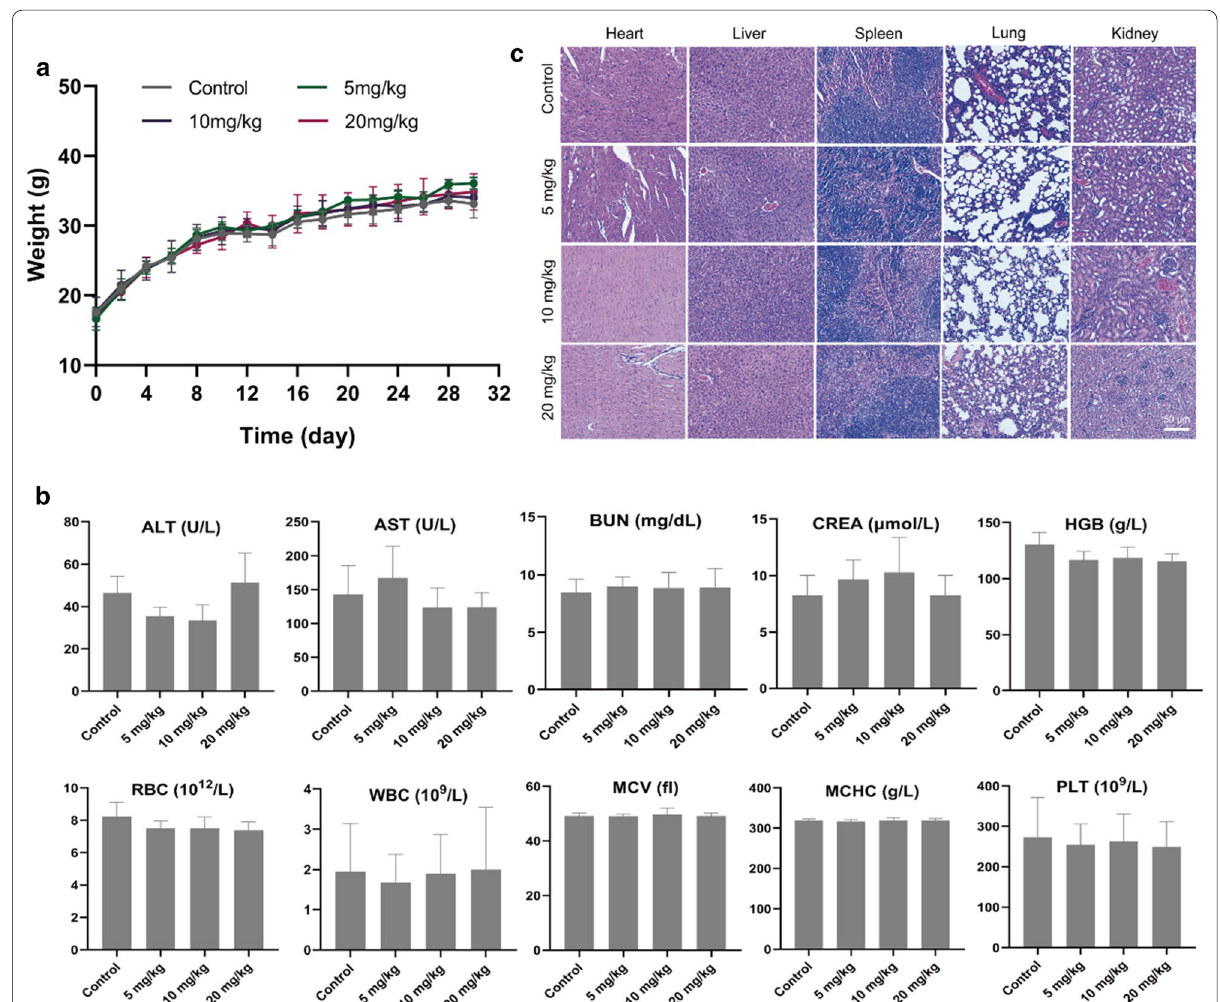
3). b The blood biochemistry and blood routine = 3). c H&E results of different organs (heart, liver, =